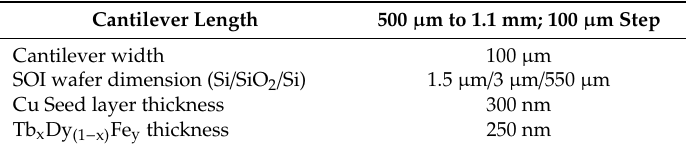
Table 1. Typical dimensions of the fabricated cantilevered structure.